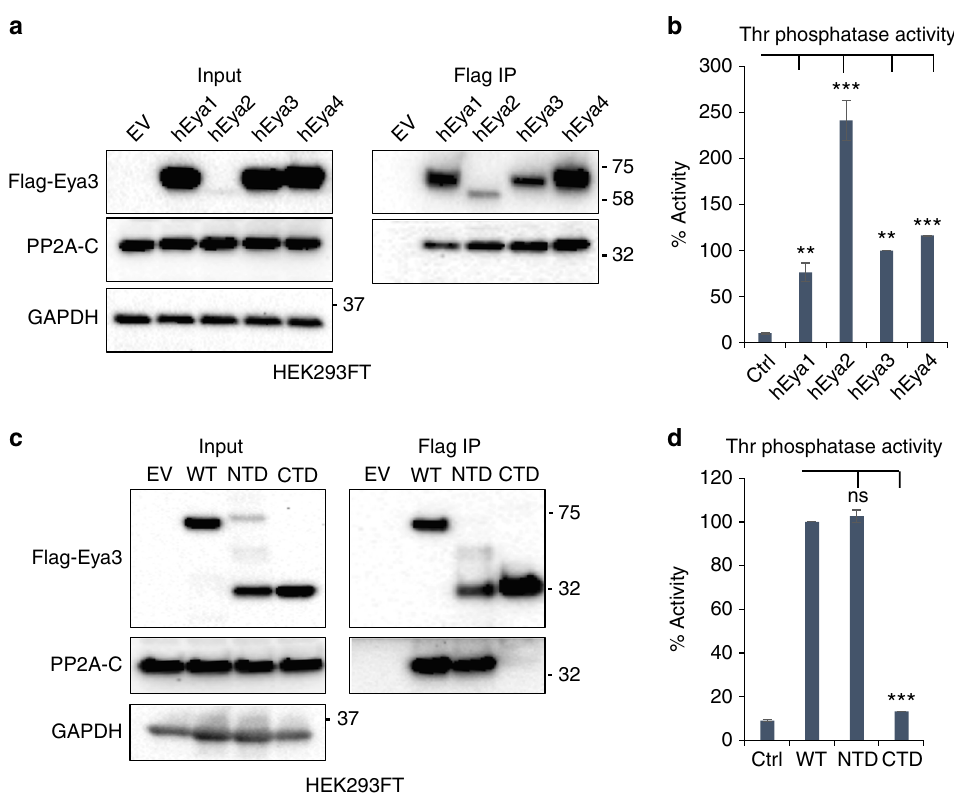
Fig. 3 All Eya family members interact with PP2A, and the N-terminal domain (NTD) of Eya3 is the main contributor to the PP2A interaction. a HEK293FT cells were transfected with EV, Flag-fused human Eya1 (hEya1), hEya2, hEya3, or hEya4. IP against Flag demonstrates the levels of PP2A-C subunit associated with Flag-hEyas. Molecular weight markers in kilodalton are labeled on the side of western blots. b Thr phosphatase activity assay was conducted using hEyas immunoprecipitated from transfected HEK293FT cells. All phosphatase activity was normalized to the amount of protein used in the assay. hEya3 Thr phosphatase activity was set to 100%. c HEK293FT cells were transfected with EV, Flag-fused wildtype (WT), NTD, or C-terminal domain (CTD) Eya3. IP against Flag demonstrates the levels of PP2A-C subunit associated with different domains of Flag-Eya3. d Thr phosphatase activity assay was conducted using different domains of Eya3 immunoprecipitated with a Flag antibody from transfected HEK293FT cells. Eya3 WT Thr phosphatase activity was set to 100%. Data shown are mean ± SD from three independent experiments. In the phosphatase activity assay, the p -value is calculated using one-way ANOVA followed by Tukey test, ** p < 0.01, and *** p <